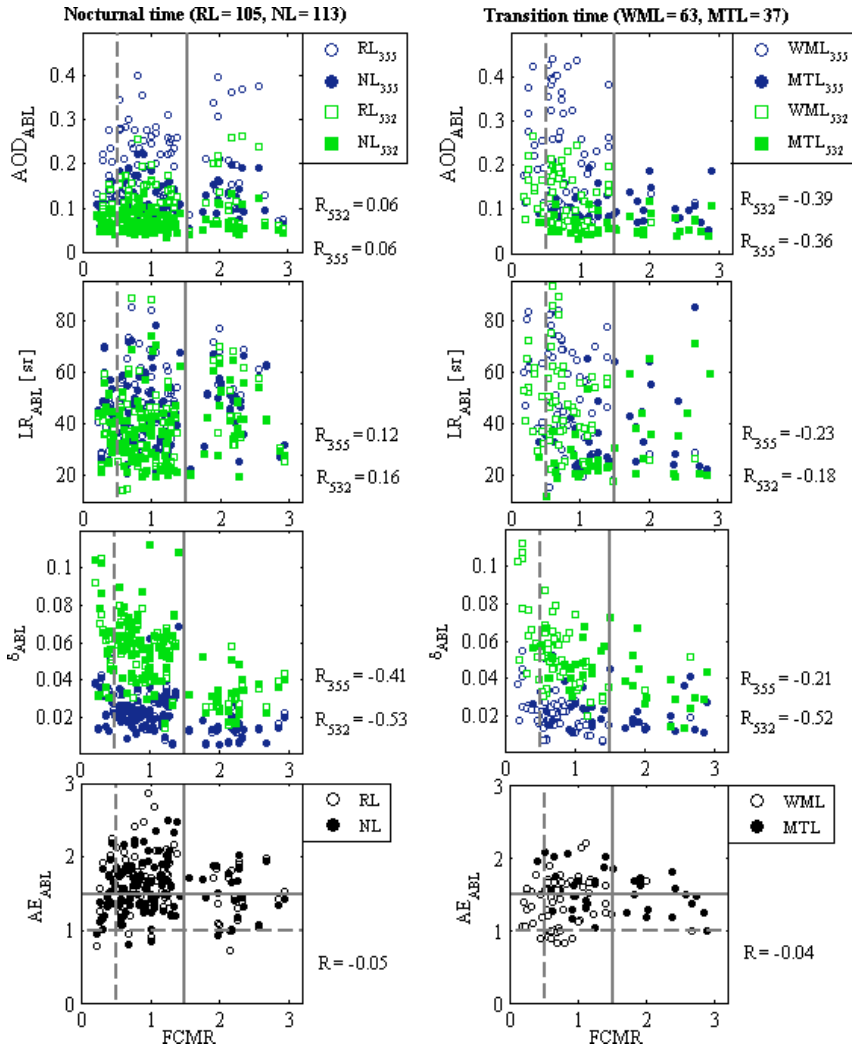
Figure 7. Hourly averaged aerosol optical depth (AOD), lidar ratio (LR), linear particle depolarization ratio ( δ ), and Ångström exponent (ÅE) derived within the atmospheric boundary layer at 355 and 532nm by the PollyXT lidar at the RS-Lab, EARLINET/ACTRIS site in Warsaw, for the July–September period of 2013, 2015, and 2016 vs. the surface fine-to-coarse mass ratio (FCMR) derived from particulate matter (PM 2 . 5 and PM 10 ) measured at the WIOS site in Ursynow, Warsaw. Thresholds of the ÅE and FCMR are marked using horizontal and vertical lines